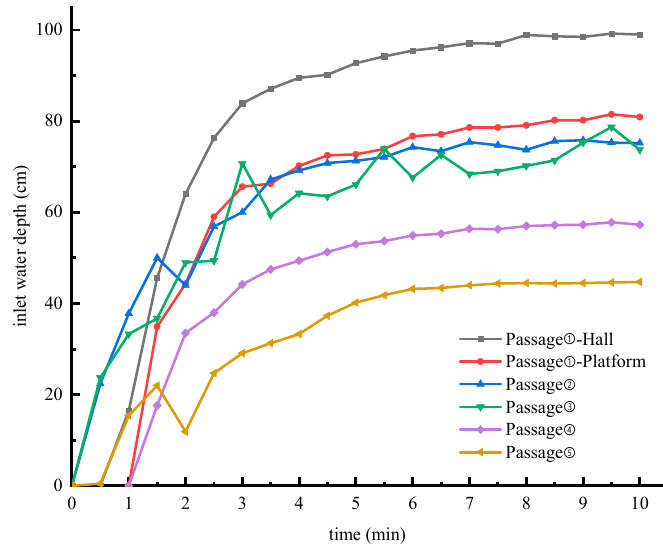
Figure 13. Pedestrian moving velocity at the entrances of exit passages as a function of time. All emergency safety passages entrances were inundated (Figure 14); emergency safety Passages 1 (cid:13) ~ 4 (cid:13) were designed to be long and narrow with multi-run stairs, so the flood stagnation phenomenon easily occurs at the entrance and rest platform. The flood water level at the entrance of Passage 1 (cid:13) at the hall floor and the platform floor, and the Passage 2 (cid:13) and Passage 3 (cid:13) connecting the service room were all more than 70 cm deep, which pedestrians would not be able to move through [45]. In the prevention of rainstorm and waterlogging disasters in subway stations, emphasis should be placed on strengthening the water blocking and drainage measures of emergency safety passages.